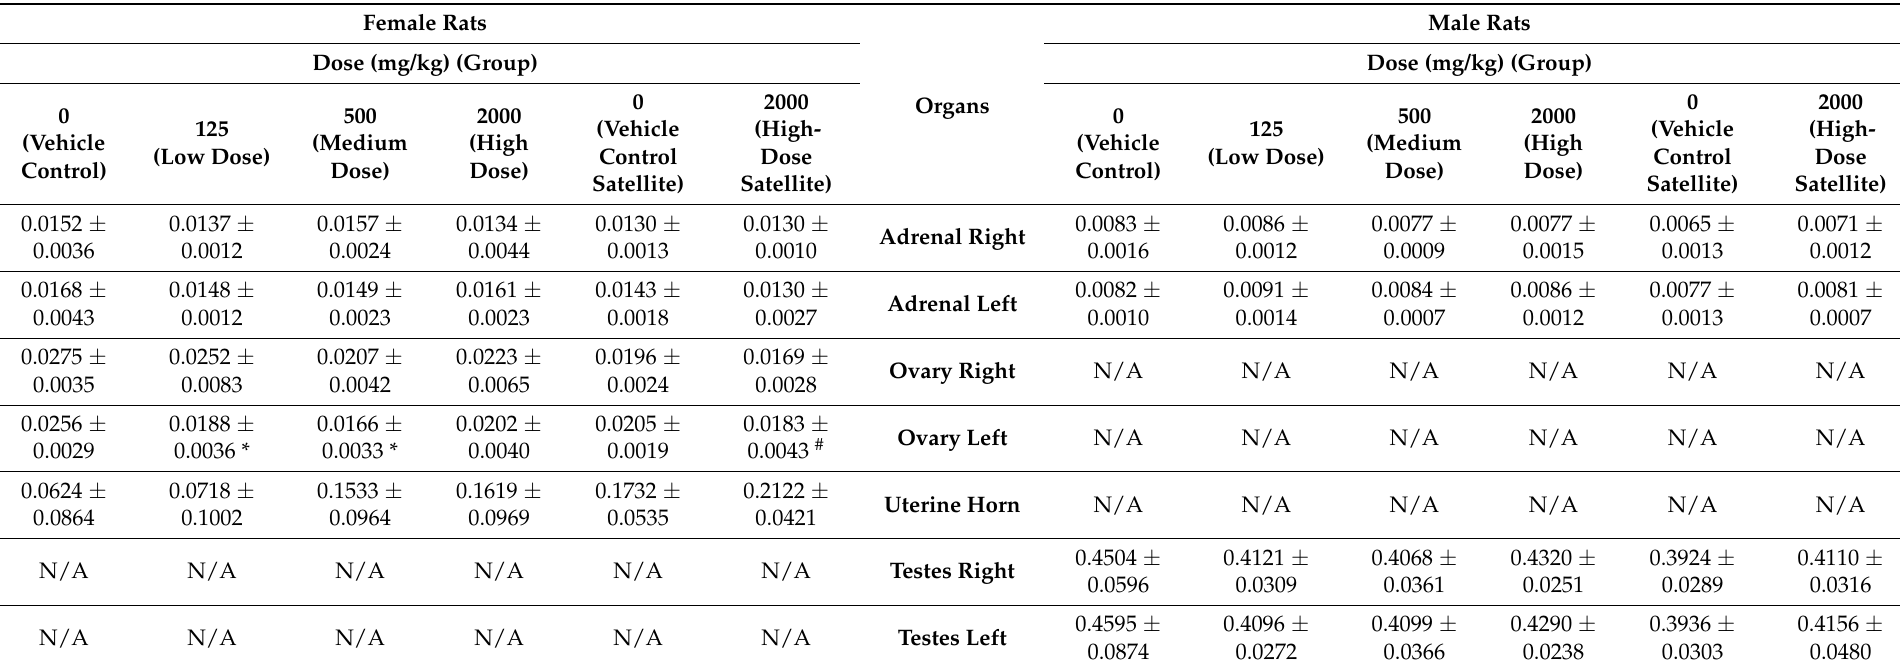
Table 11. Relative organ weight (adrenals and reproductive organs) in female and male rats. Female Rats Male Rats